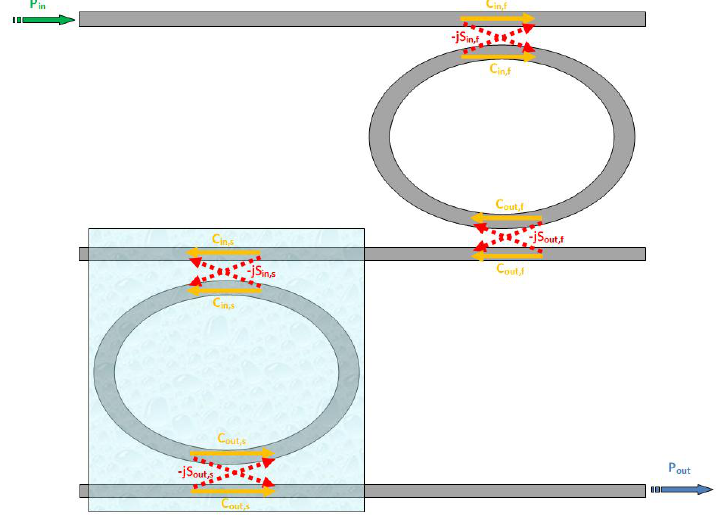
Figure 4. Schematic architecture of a typical Vernier effect-based sensor.